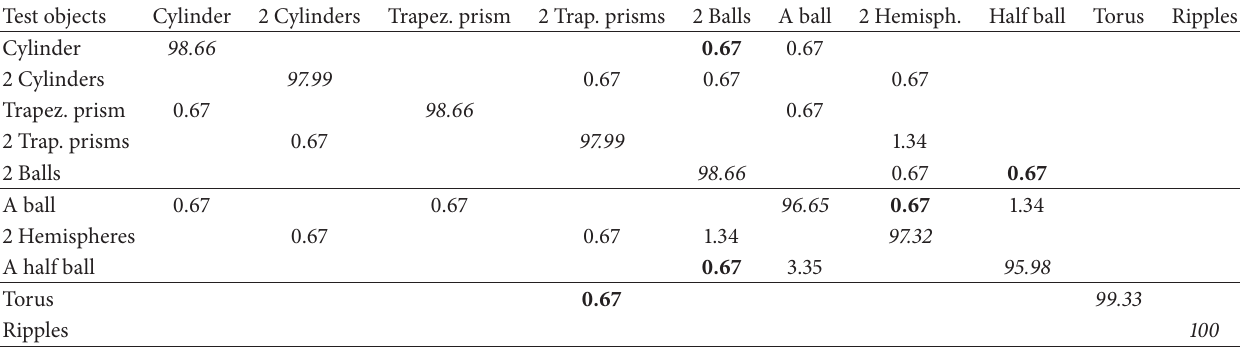
Table 2: Confusion matrix of recognition and identification (%) of virtual shapes in the parallel scanning mode at the playback velocity of the virtual trajectory of 28mm/s, averaged over all participants.